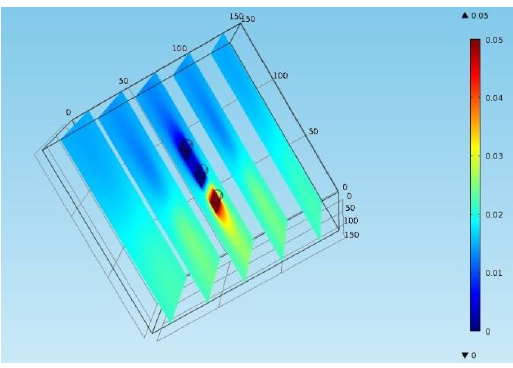
Figure 9. Electric potential contour.